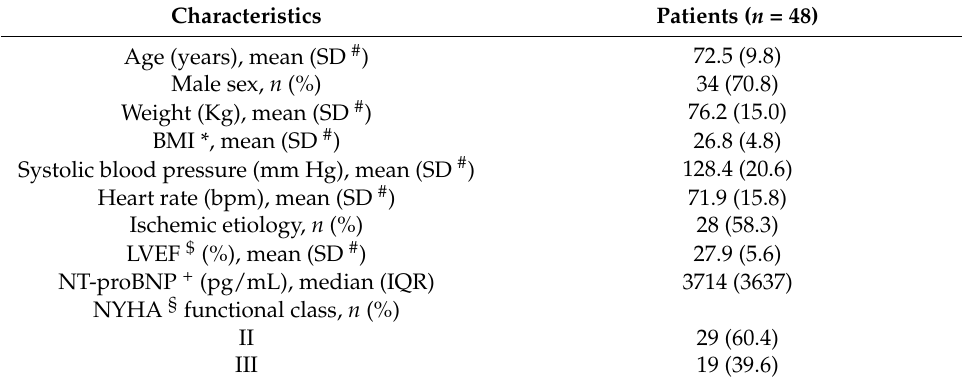
Table 1. Baseline characteristics of overall study